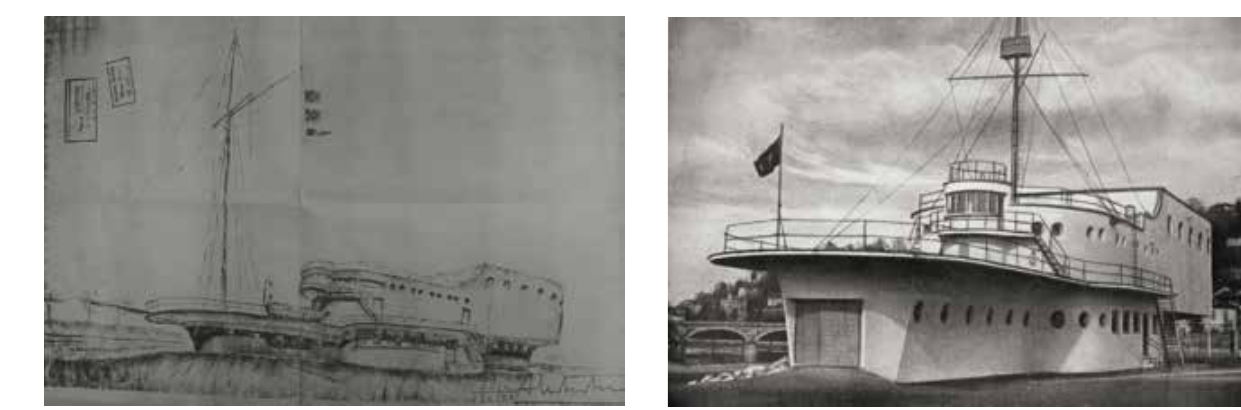
Figure 4. Historical photograph of the 'Casa del